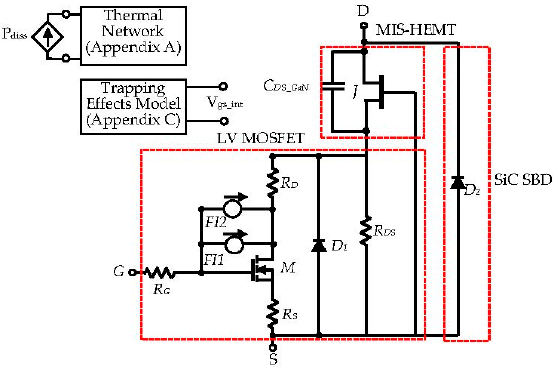
Figure 2. Fabricated cascode GaN FET simulation program with integrated circuit emphasis (SPICE) model. The approximations introduced by the adopted model for the I–V characteristics from ref [18] were added into the model. The corresponding gain k, R fill , R empty , and the capacitance C were obtained from the trapping effect example in Appendix C Figure